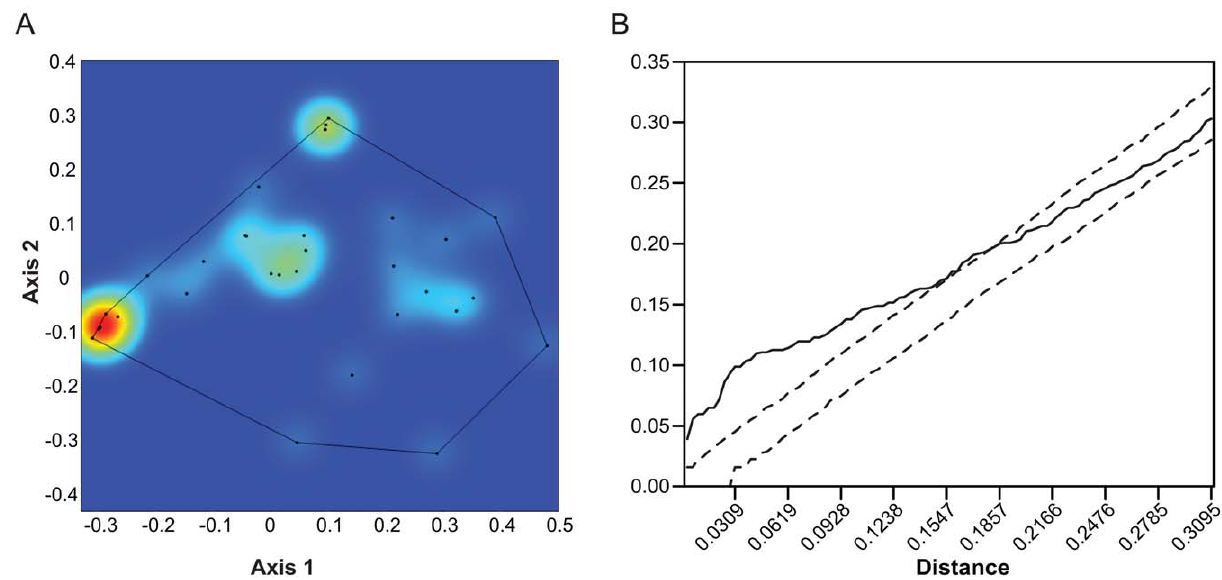
Figure 3. Point pattern analysis of the morphospace occupation pattern of extant African Carnivora. A. Kernel density plot. The same three hotspots as in Figure 2A are seen. B. Ripley’s K analysis of the patterns seen in Figure 3A. In this case, there is significant attraction between points at shorter distances (the line lies above the 95% confidence interval limits) but randomness at longer ones (the line lies within the 95% confidence envelope).